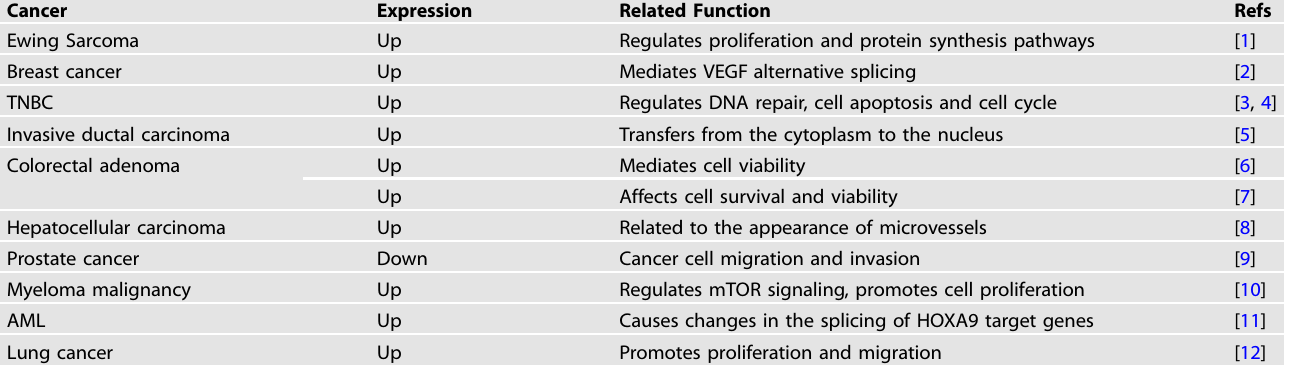
Table 1. Research application of RBM39 in